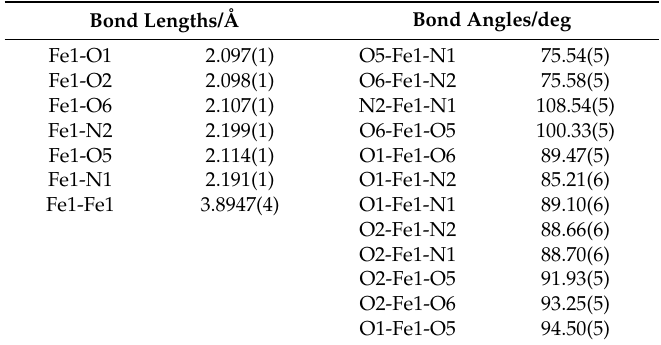
Table 2. A few Selected Bond Lengths (Å) and Bond Angles (deg) of Complex 1 .